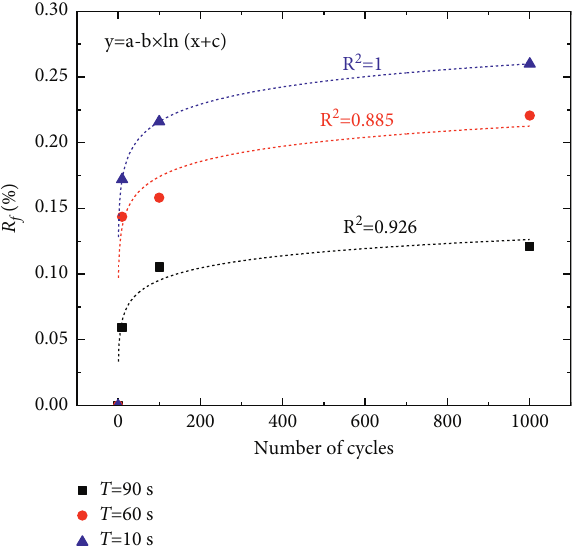
Figure 14: The failure stress ratio R f as a function of the number of